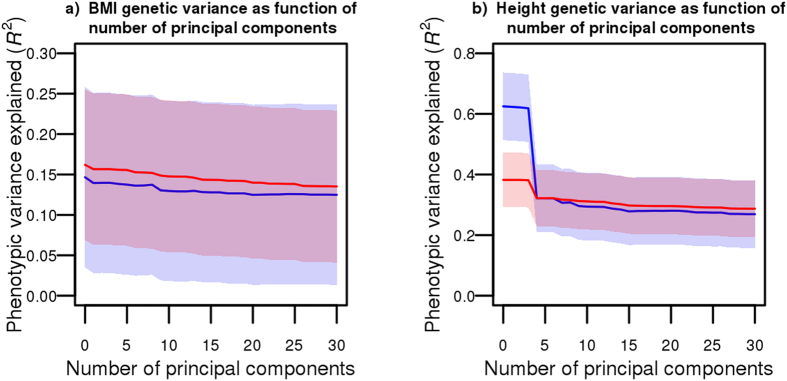
Genome-wide genetic variance estimated by summary association statistics and variance component models.The overall genetic variance estimated by summary association statistics and variance component models is illustrated as a function of number of principal components for BMI (a) and height (b). Blue lines represent estimates of genetic variance using summary association statistics with LARGV; with 95% confidence intervals illustrated as blue shaded area. Corresponding estimates for variance component models are in red.